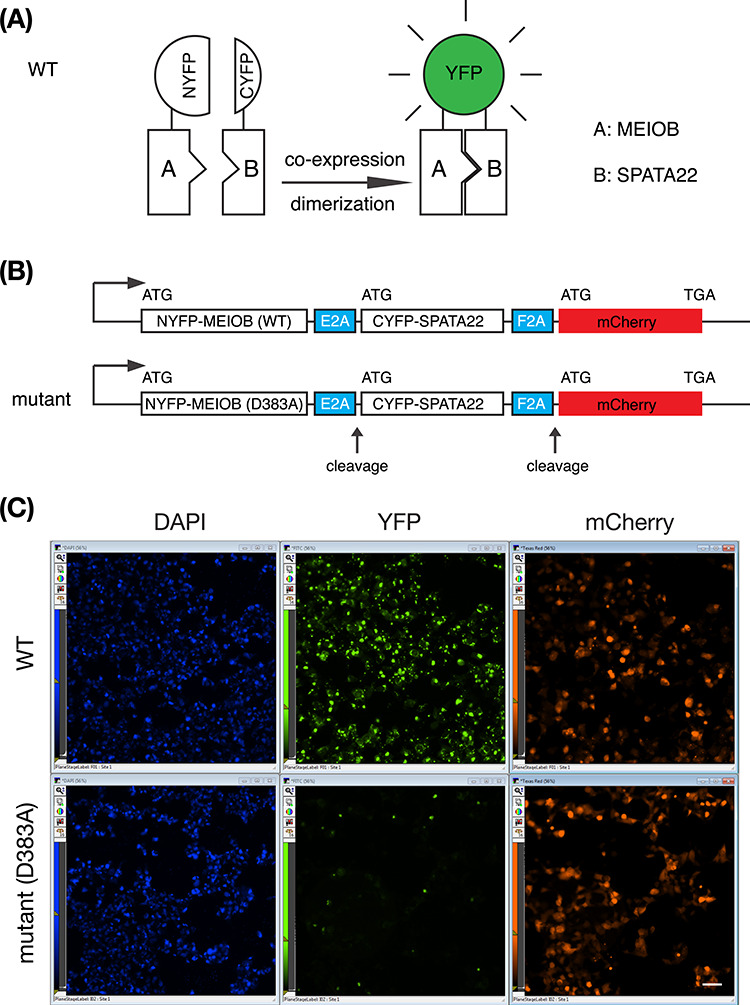
A cell-based high-content screening assay for MEIOB–SPATA22 interaction. (A) Bimolecular fluorescence complementation assay for protein–protein interactions. Binding of proteins A (MEIOB) and B (SPATA22) enables reconstitution of the fluorophore core of YFP. (B) Schematic design of a multi-protein tricistronic expression construct for the BiFC assay. Two self-cleaving 2A peptide sequences are from picornavirus. E2A: equine rhinitis A virus. F2A: foot-and-mouth disease virus. (C) Fluorescence readout of the BiFC assay. HEK293T cells were transfected with the wild-type construct or the mutant construct in the 384-well format. Cells were imaged 48 h post transfection. Only one well is shown per construct. Scale bar, 50 μm.